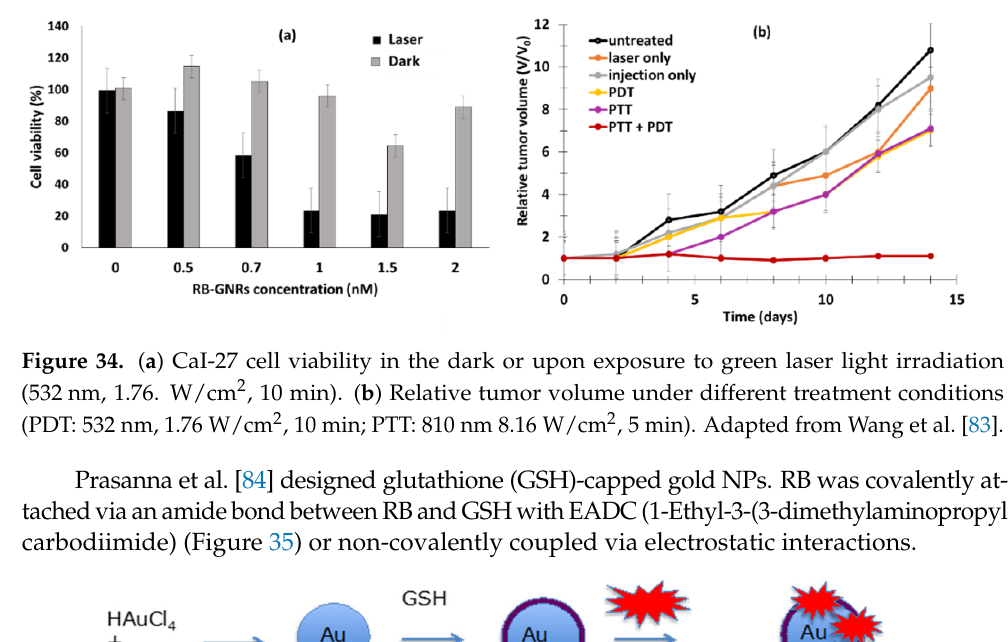
35 of 60 2.4. Gold Nanoparticles Gold NPs are assemblies of 30 to 40 million gold atoms. The size of these NPs depends on their synthesis conditions, and mainly ranges between 1 and 100 nm [79]. For centuries, gold NPs have been used in clinical chemistry, laser phototherapy of cancer cells and tumors, targeted delivery of drugs, DNA and antigens, optical bioimaging, and monitoring of cells, tumors, and tissues using state-of-the-art detection systems. They are used in diagnosis, therapy, prevention, and hygiene. They can be used in these applications owing to their unique physical and chemical properties. In particular, the optical properties of gold NPs are determined by their plasmon resonance, which is associated with the collective excitation of conduction electrons and localized in the wide region, from visible to infrared (IR), depending on the size, shape, and structure of the particles. Having discovered the properties of biocompatibility and photostability possessed by gold NPs, scientists have also been attracted to their exceptional photophysical and optical properties [80,81]. These properties have led researchers to apply these NPs in cancer diagnosis and therapy [82]. Wang et al. [83] synthesized a gold nanorod with a diameter of 13 ± 2 nm and a length of 52 ± 4 nm in which RB was encapsulated (RB-GNRs) for application in PTT–PDT . The seed-mediated growth method was followed, and PAH was used to modify the surface of the CTAB-coated GNRs. RB was then adsorbed onto the surface. 1 O 2 production was observed in vitor via ABDA in water (ABDA absorption decreased by 92% with light and RB-GNRs, while the reduction was only 15% without light or without RB, while a decrease of 85% was observed with RB alone) and DCFH-DA. In vitro experiments were performed on Cal-27 cells and a home-made light-emitting diode at a wavelength of 530 ± 15 nm (170 mW/cm 2 for 90 s). Total cell survival after light illumination for 12 h was 19%, and 26.3% after light illumination for 24 h. In vivo experiments were performed on Male Syrian